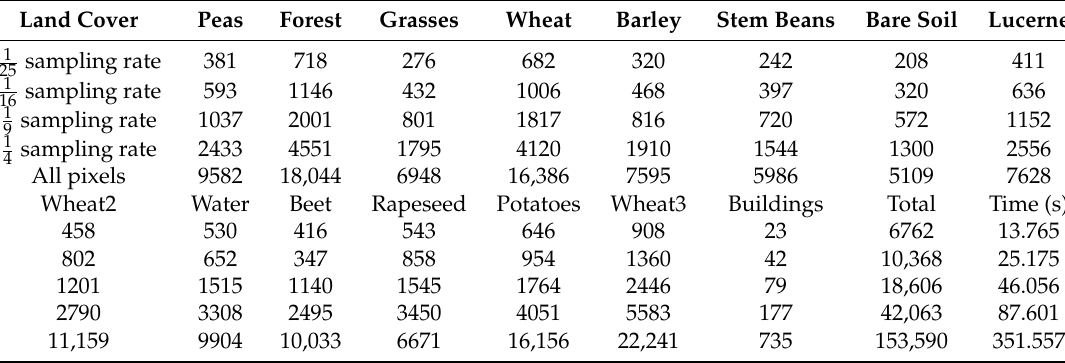
Table 1. Pixels of dataset Flevoland with different down-sampling